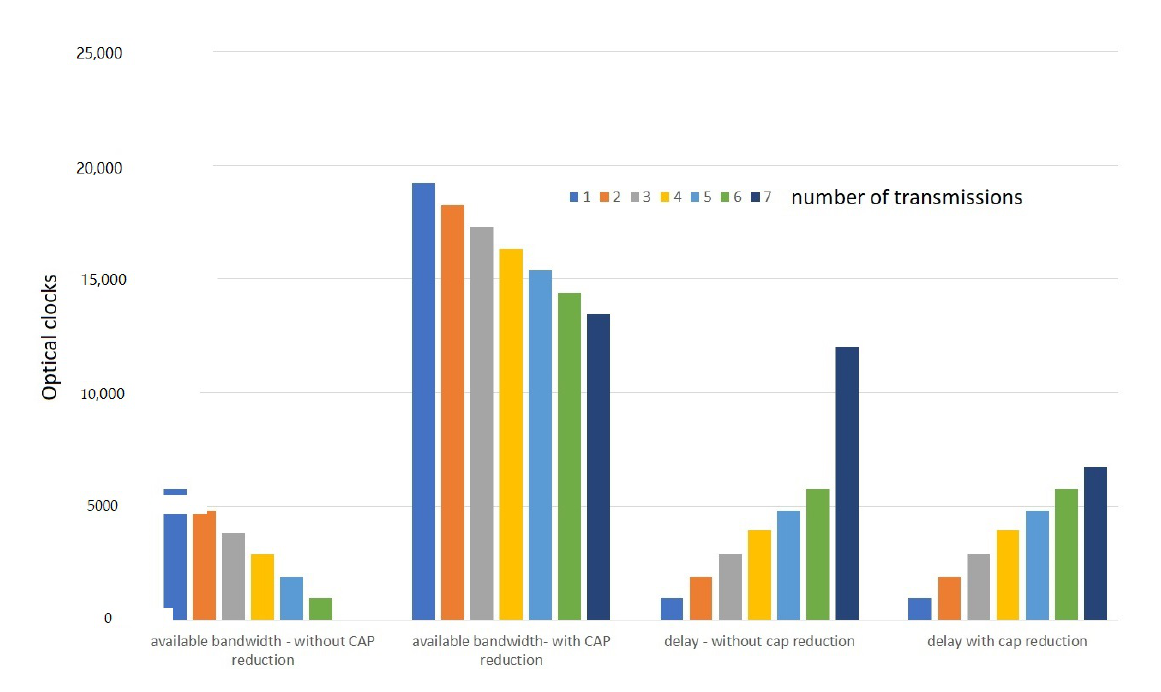
Figure 11. GTS scalability analysis of IEEE